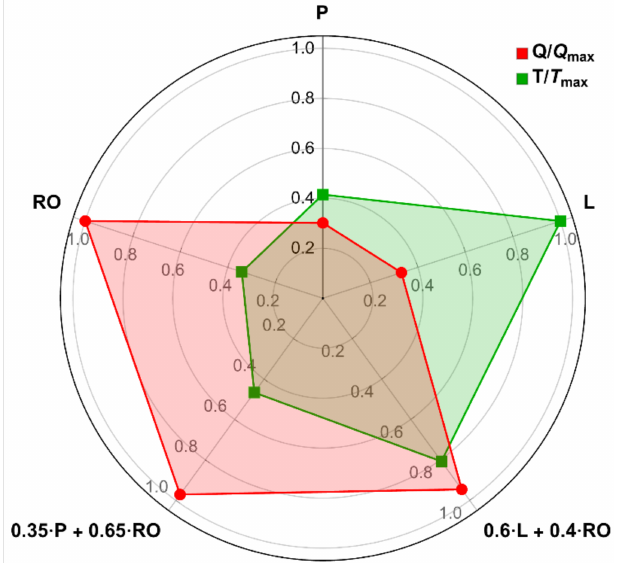
Figure 4. Characteristic temperatures (green) recorded during the allothermal conversion of compos- ite fuels and their components (normalized to the highest temperature) and high calorific values of the fuels (normalized to the highest value). Normalization factors: T max = 1350 ◦ C, Q max = 38.5